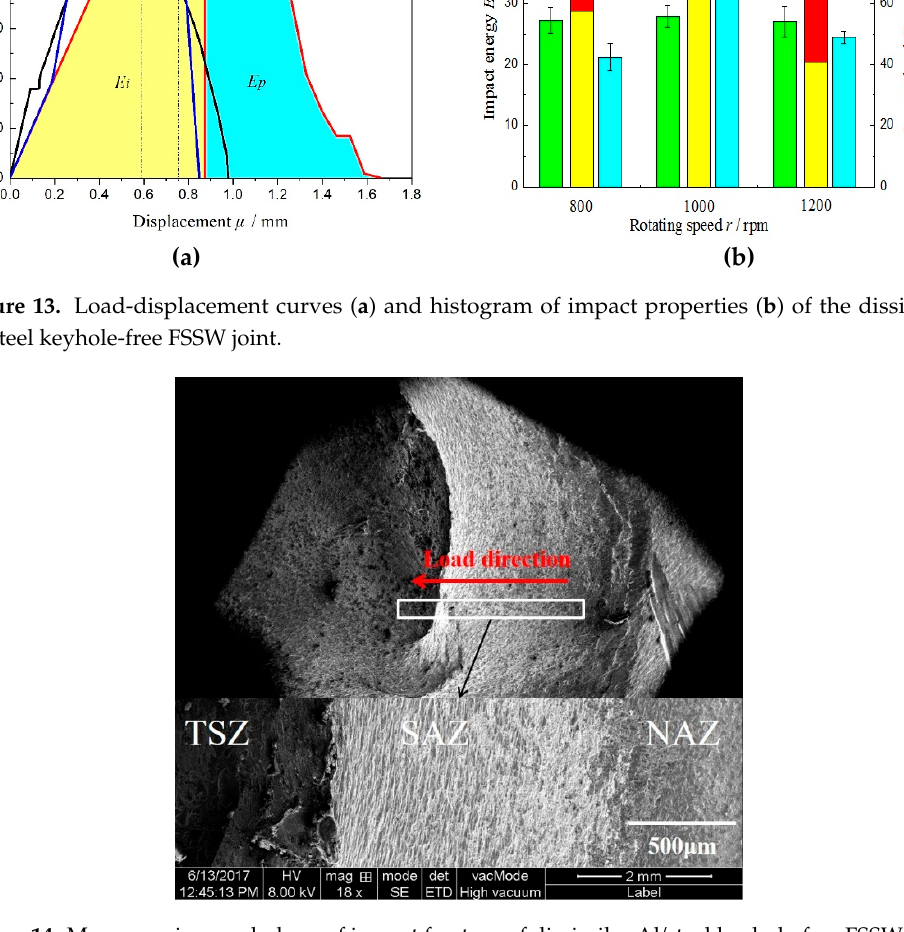
Figure 14. Macroscopic morphology of impact fracture of dissimilar Al/steel keyhole-free FSSW joint.